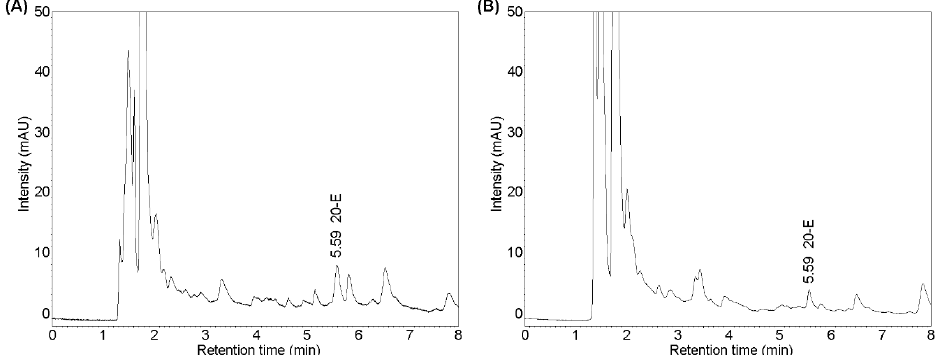
Figure 5. Representative chromatograms obtained for extract of Spinacia oleracea L using the proposed NADES-SLE-UHPLC-UV method (spinach leaves ( A ) and spinach stalks ( B )).